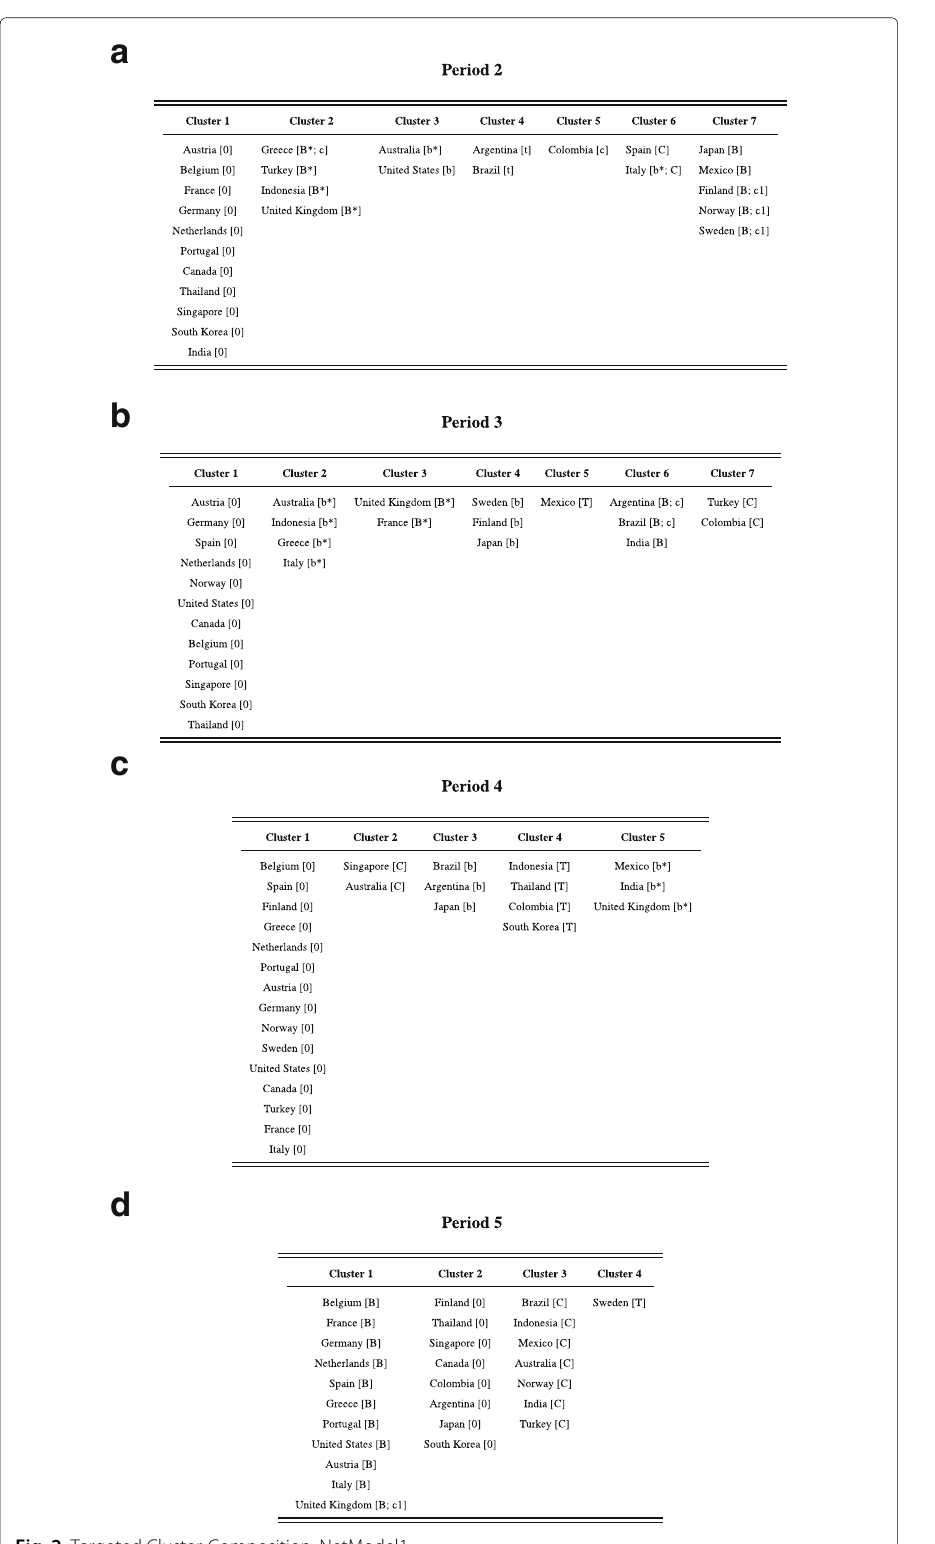
Fig. 2 Targeted Cluster-Composition: